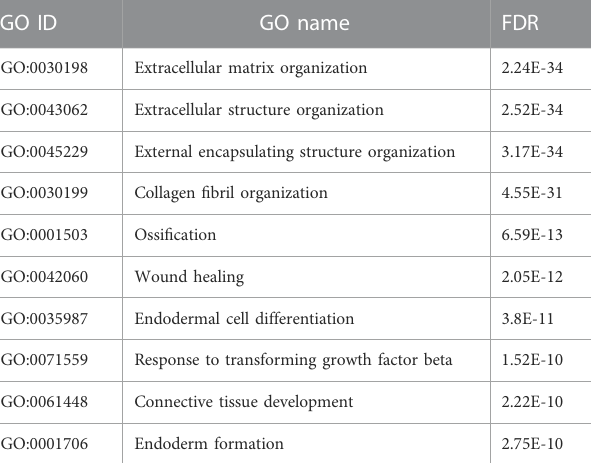
TABLE 4 Functional annotation of hub genes using TissueNexus. GO